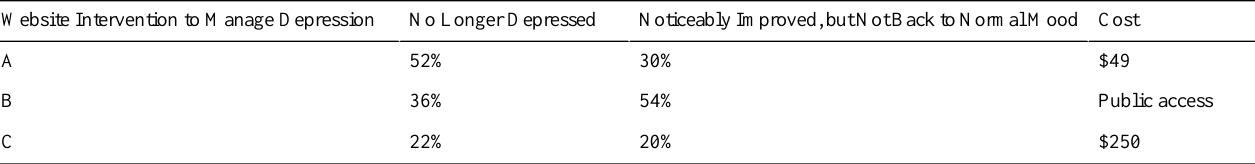
Table 2. Simplified illustration of how a central website for evidence-based Internet interventions might present data for a specific demographic profile CostNoticeably Improved, but Not Back to Normal MoodNo Longer DepressedWebsite Intervention to Manage Depression